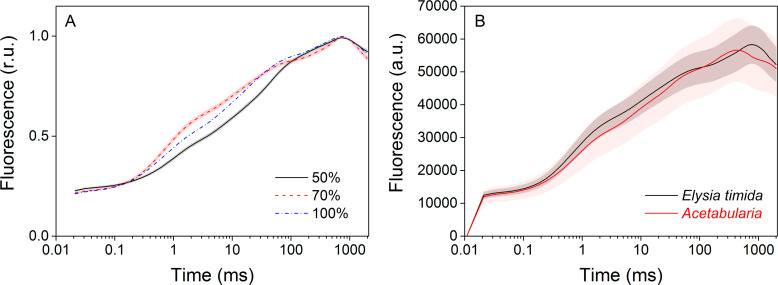
Technical considerations of the OJIP fluorescence induction measurements.(A) Increasing the saturating pulse intensity from 50% of the maximum (black solid line) to 70% (red dashed line) or 100% (PPFD 3000 µmol m−2s−1; blue dash-dot line) in E. timida measurements alters the O-J-I phases, but the intensity of the saturating pulse does not change the time required to reach maximum fluorescence. The data for the saturating pulse intensity 70% are taken from Figure 3A. The curve for the 50% saturating pulse represents an average from 12 biological replicates, and a representative curve is shown for the 100% intensity measurement, because raising the saturating pulse intensity to > 70% often resulted in oversaturation of the fluorescence signal in E. timida. (B) Original, unnormalized fluorescence traces from the data shown in Figure 3A, representing averages from 10 (E. timida) and 12 (Acetabularia) biological replicates. Shaded areas around the curves represent SE. All E. timida data are from individuals taken straight from the feeding tanks, without an overnight starvation period.